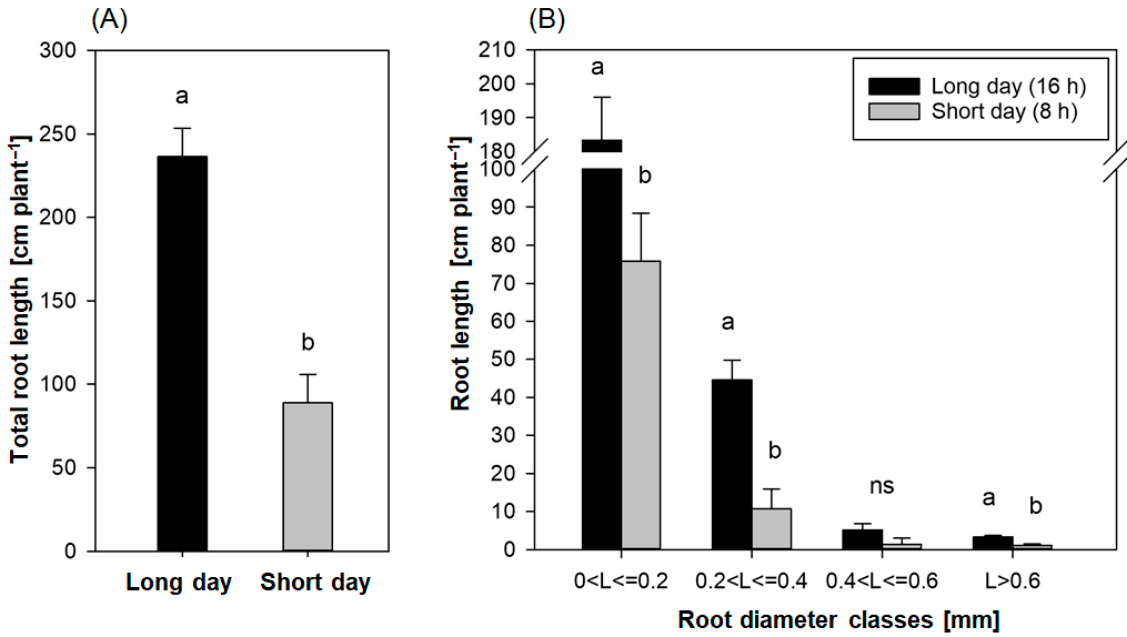
Figure 3. ( A ) The total root length; ( B ) distribution of the root length into different diameter classes (0–0.2 mm, 0.2–0.4 mm, 0.4–0.6 mm, and >0.6 mm) of yellow maca plants grown in rhizoboxes under controlled conditions at long (16 h) or short (8 h) day length. The measurements were performed at 88 DAS. Results represent mean values ± SEM of three independent replicates. Different letters indicate significant differences between treatments ( p ≤ 0.05), ns = not